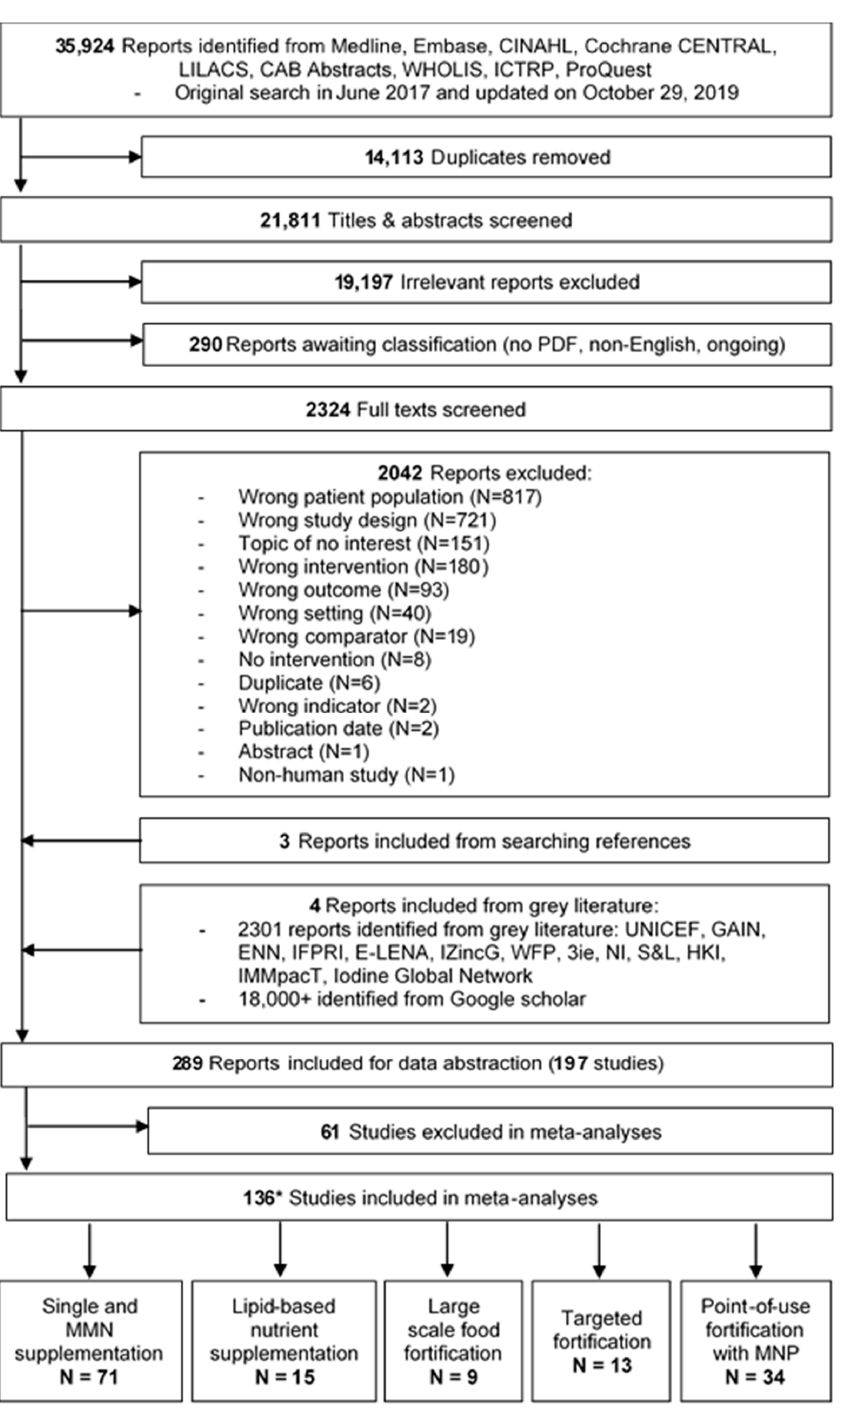
Figure 1. Screening and selection of studies included in the meta-analysis. *Some studies had multiple intervention arms that included different intervention types.